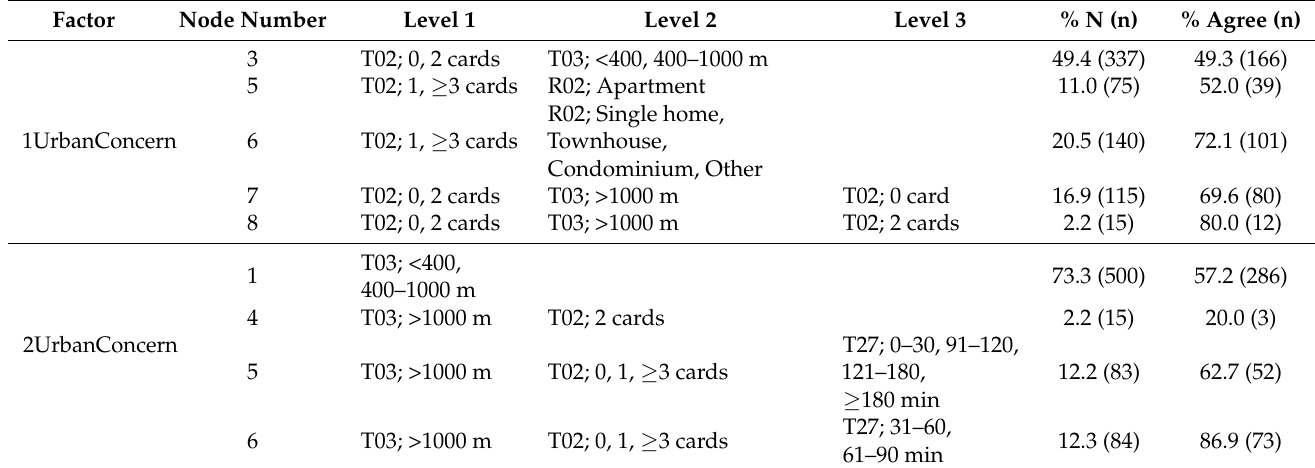
Table 7. Relevant segmentation of attitude toward not choosing to live in an urban area due to concern about infection and decision rule for terminal